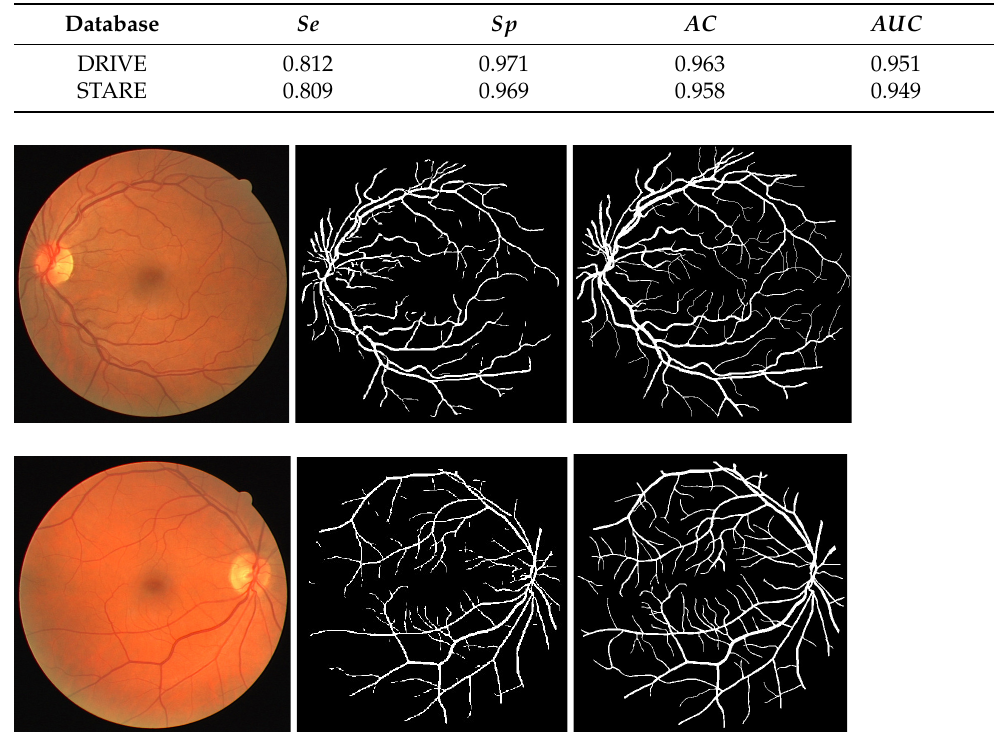
Table 1. Analysis of Performance on DRIVE and STARE Databases.